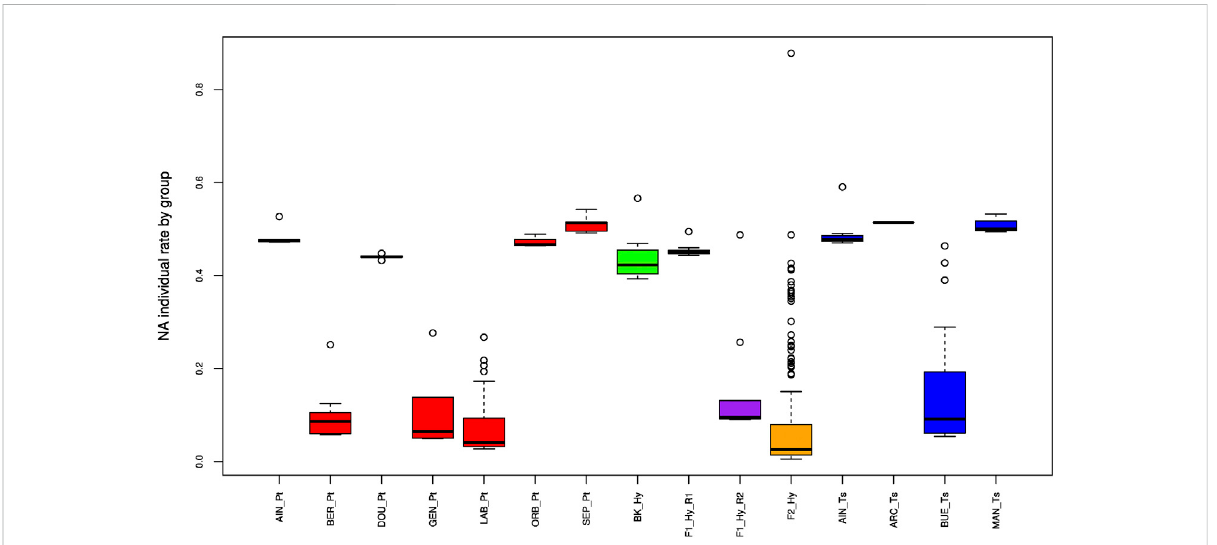
FIGURE 2 Boxplot of themissing data rate for thedifferentgroups (see Table 1).In red, P. toxostoma populations (AIN_Ptfor Ain River,DOU_Pt for Doubs River, ORB_Pt for Orbieu River, BER_Pt for Berre River, GEN_Pt for genitors, LAB_Pt for laboratory specimens, SEP_Pt for Serre-Ponçon Lake); in blue, T. souf fi a populations (AIN_Ts for Ain River, ARC_Ts for Archidiacre site on Durance River, BUE_Ts for Buech River, MAN_Ts for Manosque on Durance River); in purple, F1_Hy_R1 for fi rst run of F1 laboratory specimens, and F1_Hy_R2 for second run of F1 laboratory specimens; in orange, F2_Hy for F2 specimens; in green, BK_Hy for backcrossed laboratory specimens between F1 and P. toxostoma laboratory specimens.